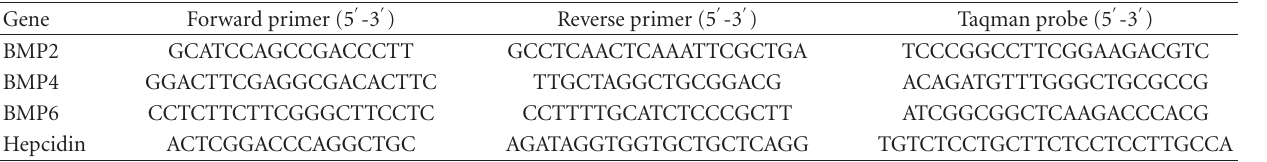
Figure 3: Smad2 Activation. The phosphorylation of Smad2 protein in the liver lysates of mice fed with regular (control) or ethanol- containing (alcohol) Lieber-De Carli liquid diets was determined by western blotting employing an anti-phospho-Smad2 antibody, as described in Materials and Methods. (b) An antibody recognizing the total levels of Smad2 protein was employed as a control to confirm equal protein loading. (c) Autoradiographs from di ff erent experiments ( n = 3) were scanned by a densitometer, and phospho-Smad2 (p- Smad2) expression in each sample was quantified by normalizing to total Smad2 protein expression. Normalized phospho-Smad2 expression in alcohol-treated mice was expressed as fold expression of that in control mice. Table 1: Mouse-specific sequences of real-time quantitative PCR probe and